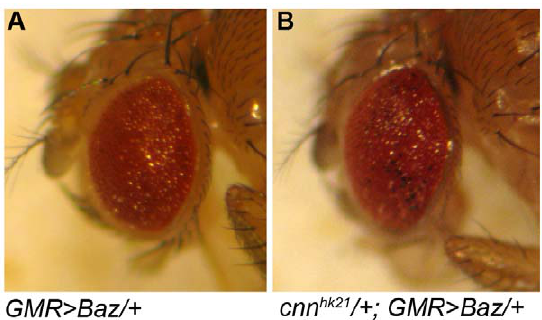
Figure 2. Genetic interaction of baz and cnn in Drosophilaeye . (A–B) Adult eye phenotype of + / + ; GMR . Baz / + (A) and cnn hk21 / + ; GMR . Baz/ + (B).